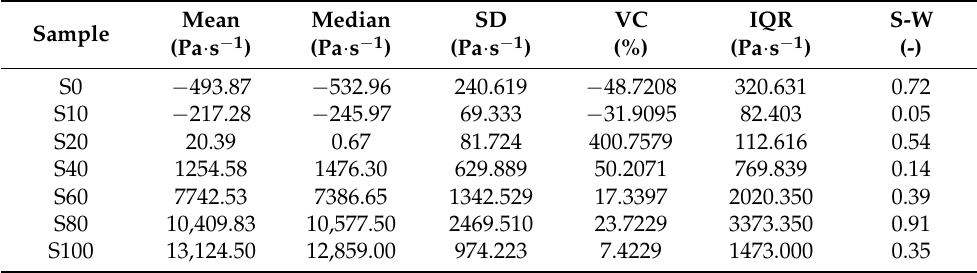
Table 2. Exploratory data analysis—hysteresis